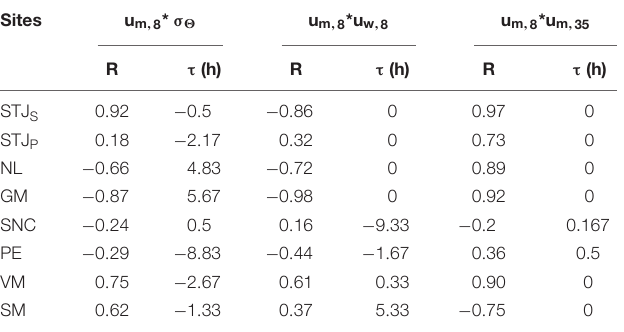
TABLE 5 | Cross-correlations between mean direction velocity component at 8 masf (u m , 8 ) with sigma-theta ( σ (cid:50) ), vertical velocity component at 8 masf (u w , 8 ) and the mean direction velocity component at 35 masf (u m , 35 ) with maximum correlation (R) and offset ( τ ) in hours. Sites u m , 8 * σ (cid:50) u m , 8 * u w ,